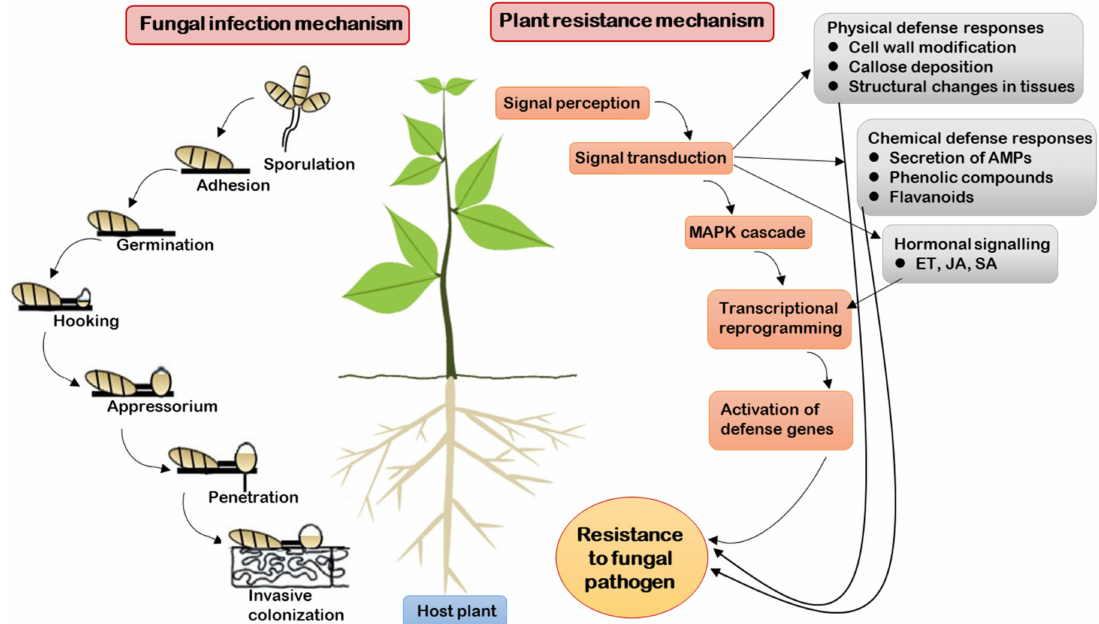
Figure 1. Schematic representation of the various steps involved in the fungal infection process and the general mechanism of the defense response of the host plant machinery to combat the fungal pathogen and to provide